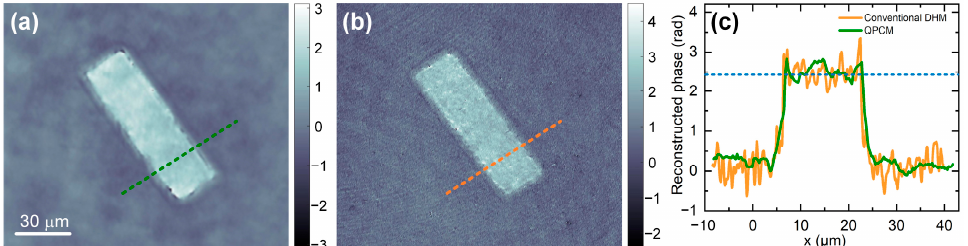
Figure 4. Comparison of PCI-QPCM and conventional DHM on imaging of phase-step. ( a , b ) The reconstructed phase images (rad) of PCI-QPCM and conventional DHM. ( c ) The phase distributions along the two dash lines in ( a , b ), the blue dash line is the real phase value (ground-truth) of phase-step.